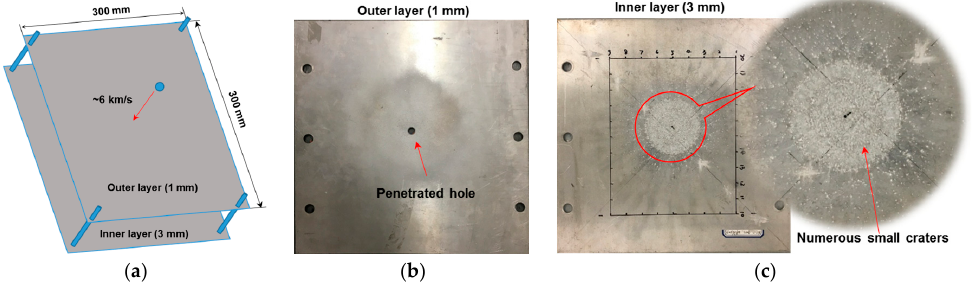
Figure 8. ( a ) Schematic of the Hypervelocity Impact (HVI) experiment; ( b ) photograph of the outer layer being penetrated; and ( c ) photograph of the inner layer with multitudinous small craters.